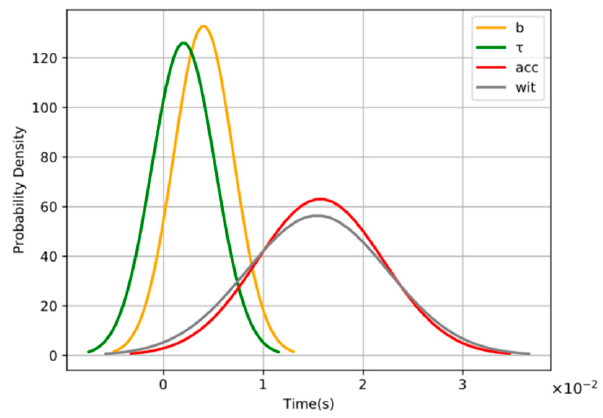
Figure 7. The distribution trend of computing overhead with different parameters.